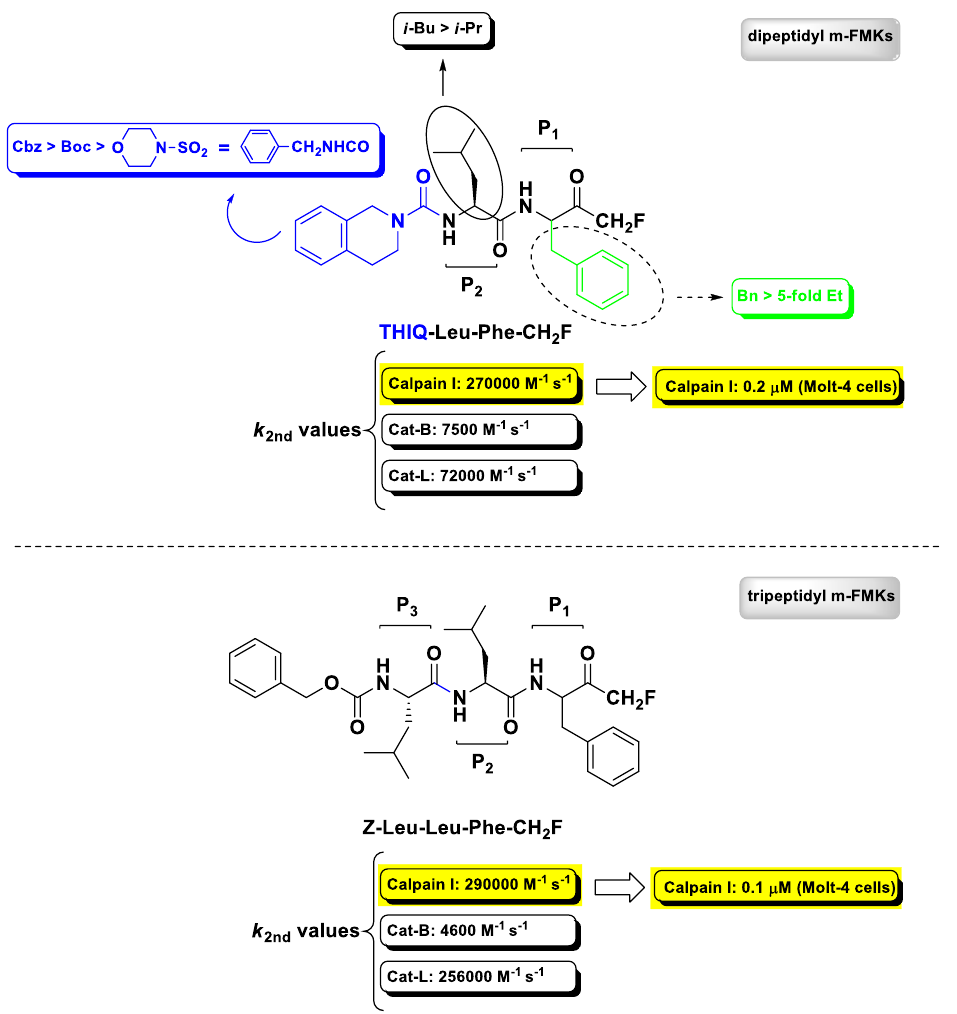
Figure 6. Chemical structure, SAR analysis, and biological activity of the most relevant m-PFMKs developed by Chatterjee S. et al. mainly as calpain I inhibitors.